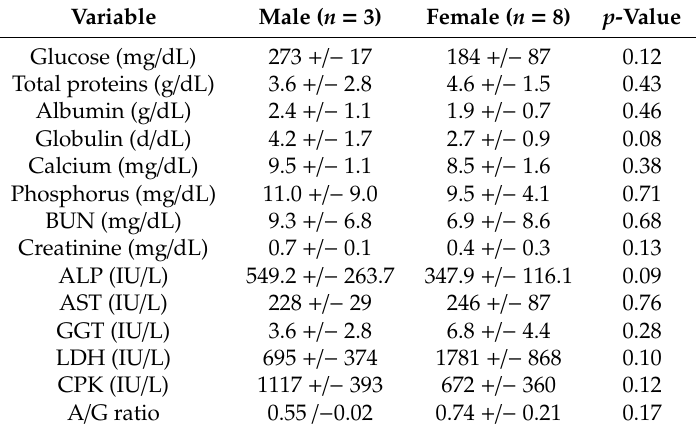
Table 6. Mean ± standard deviation of blood biochemistry variables of captive black-faced ibis ( Theristicus melanopis ) according to sex (N =